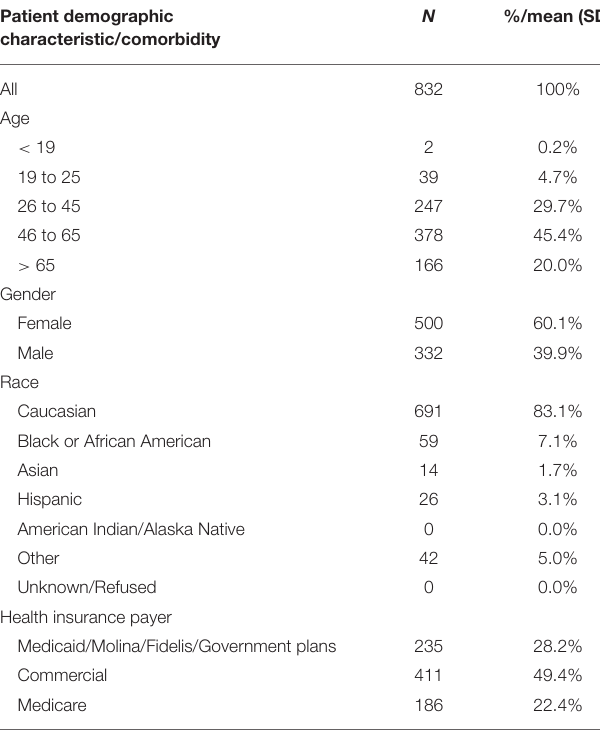
TABLE 1 | Baseline demographic characteristics of patients presenting to the HBC. Patient demographic characteristic/comorbidity